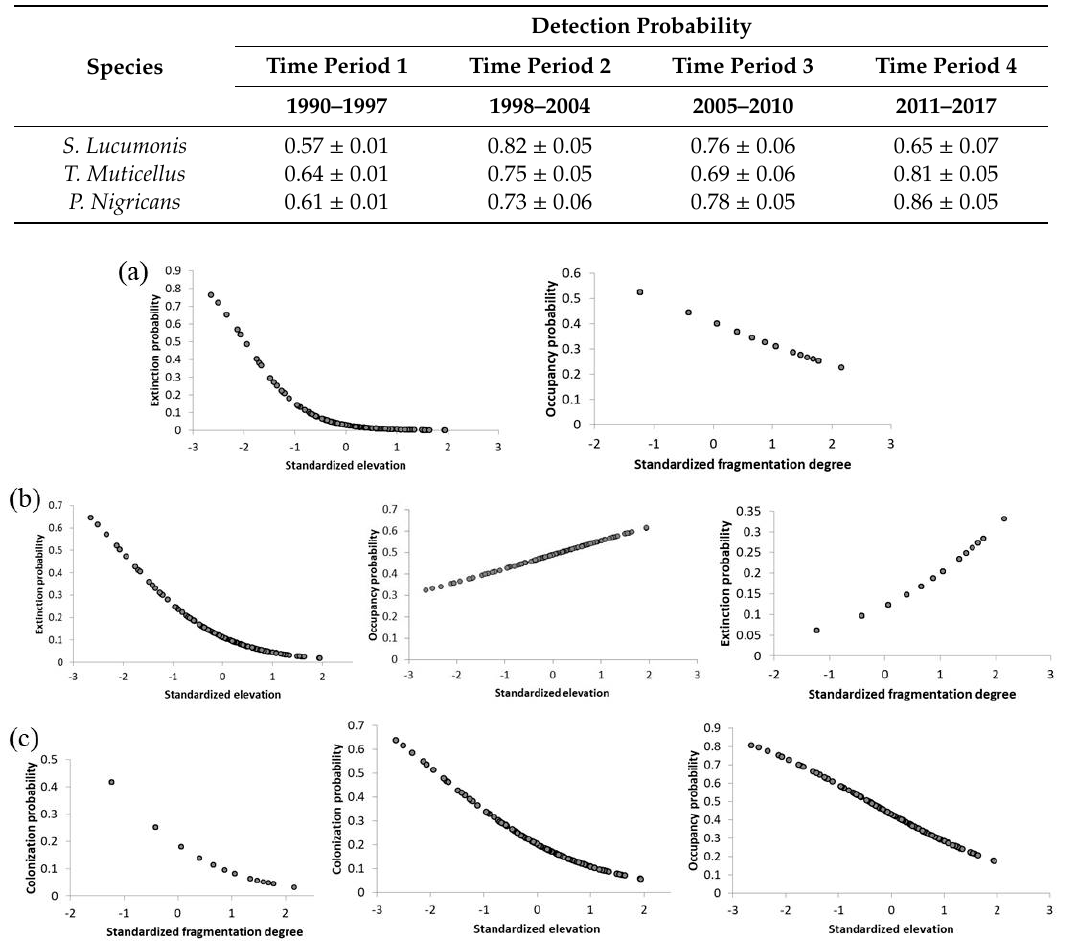
Figure 11. Effects of elevation and degree of river fragmentation on occupancy, colonization and extinction probabilities from the best informative models for: ( a ) Squalius lucumonis , ( b ) Telestes muticellus and ( c ) Padogobius nigricans .